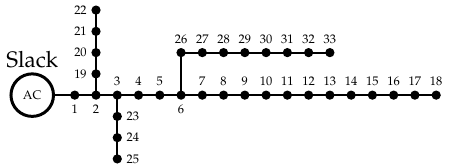
Figure 5. Electrical diagram of the 33-bus test system.